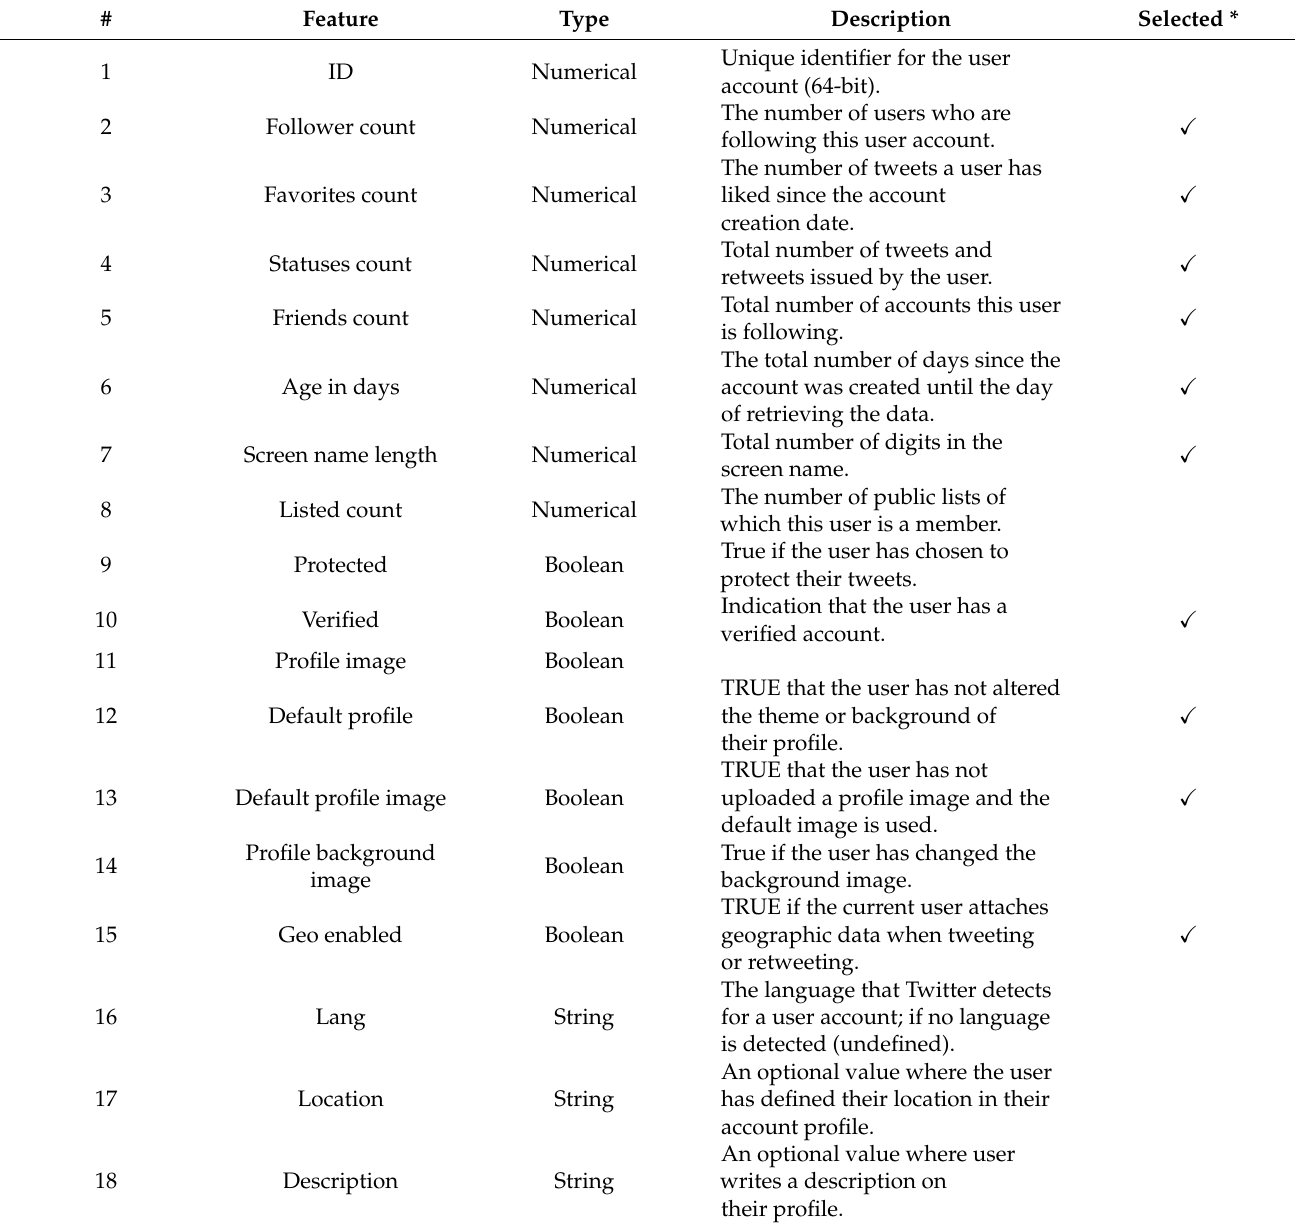
Table 2. List of extracted profile features and their